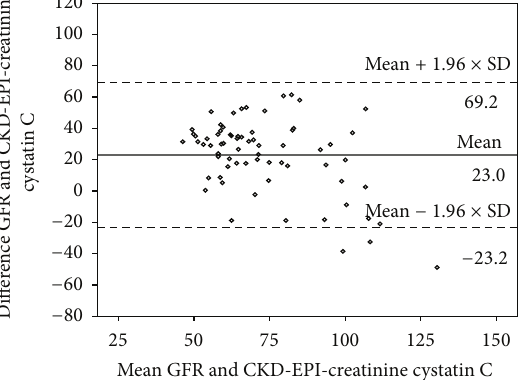
Figure 3: Bland-Altman plot for the agreement between isotopic GFR and the other GFR estimating